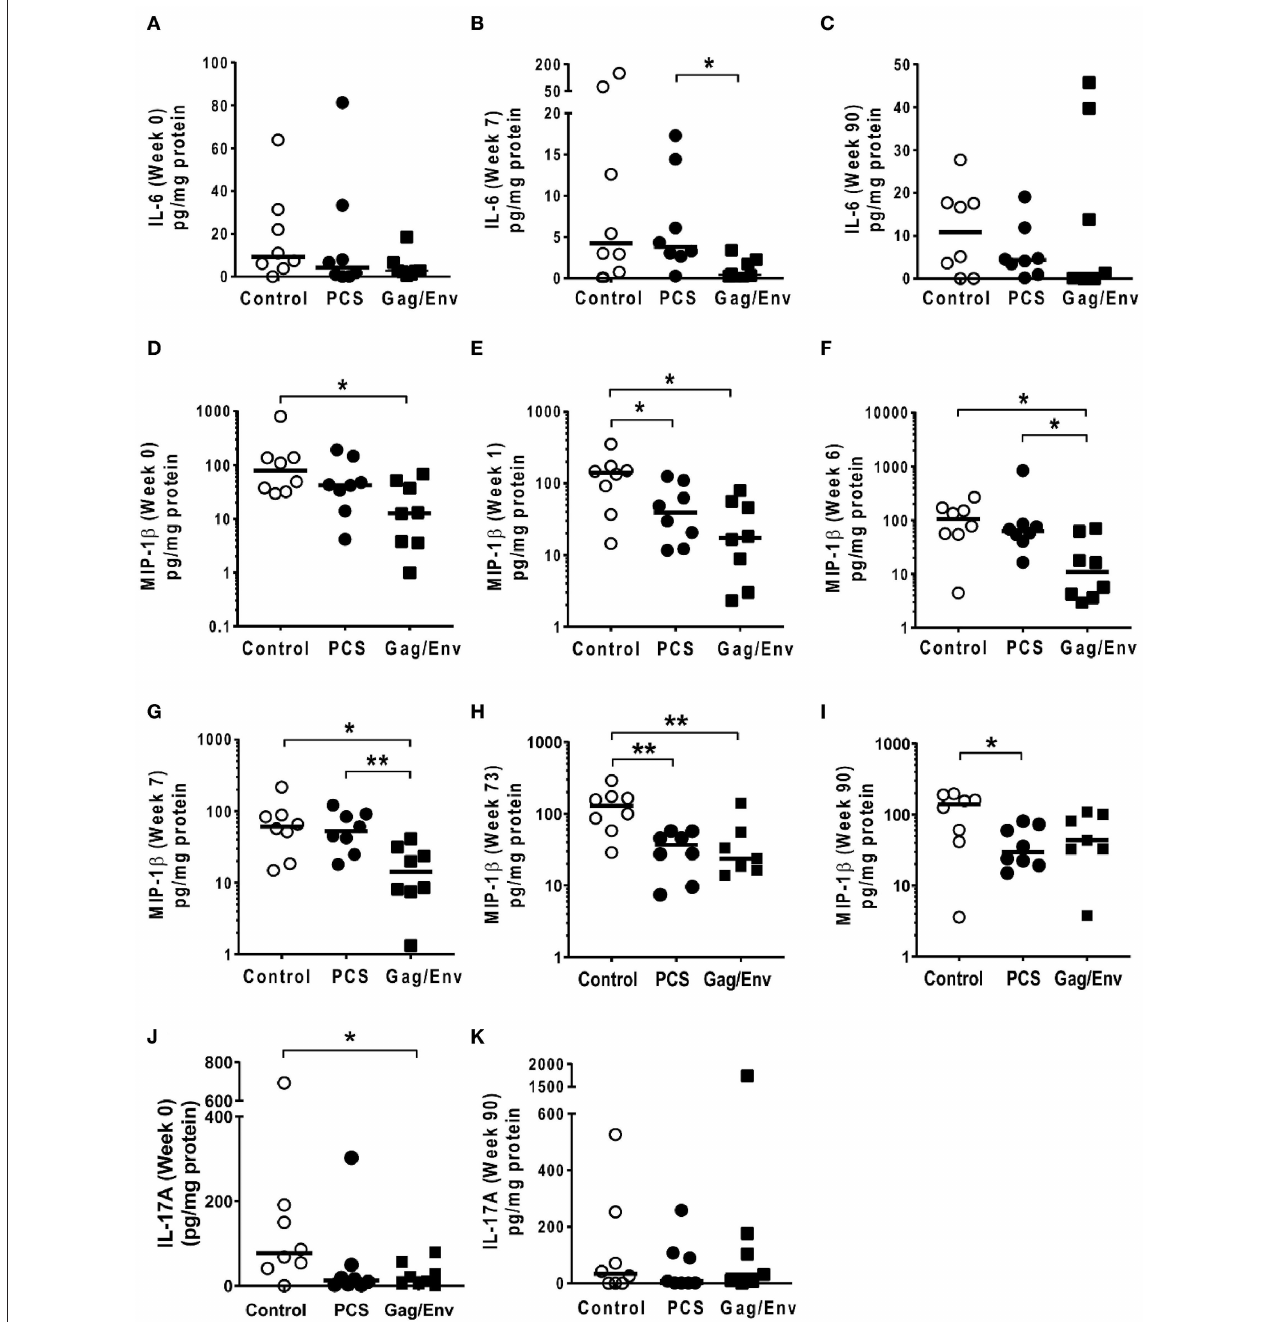
FIGURE 9 | Significant differences in CVL levels of IL-6, MIP-1 β , and IL-17A among the 3 vaccine groups at different time points including Week 0 and 90 analyzed using Mann-Whitney t -test. Data presented as values from individual monkeys with median. (A–C) IL-6 (D–I) MIP-1 β (J,K) IL-17A. n = 8 monkeys/group ( n = 7 for Gag/Env). Experiments were run in duplicates. * P < 0.05 and ** P < 0.01. Non-significant differences between groups were not included.